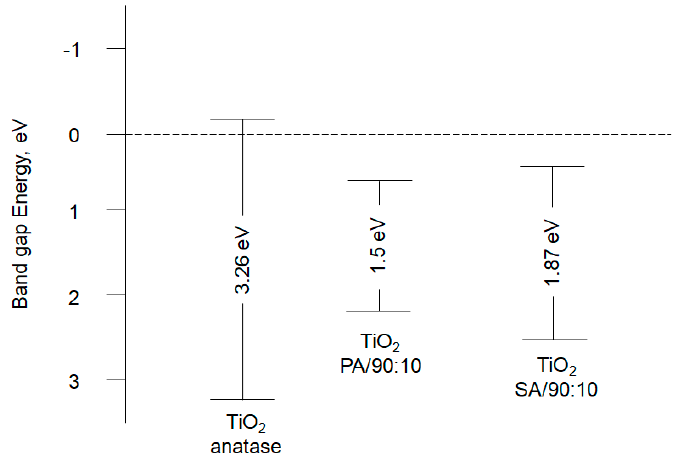
Figure 4. Valence and conduction bands of the tested photocatalysts.